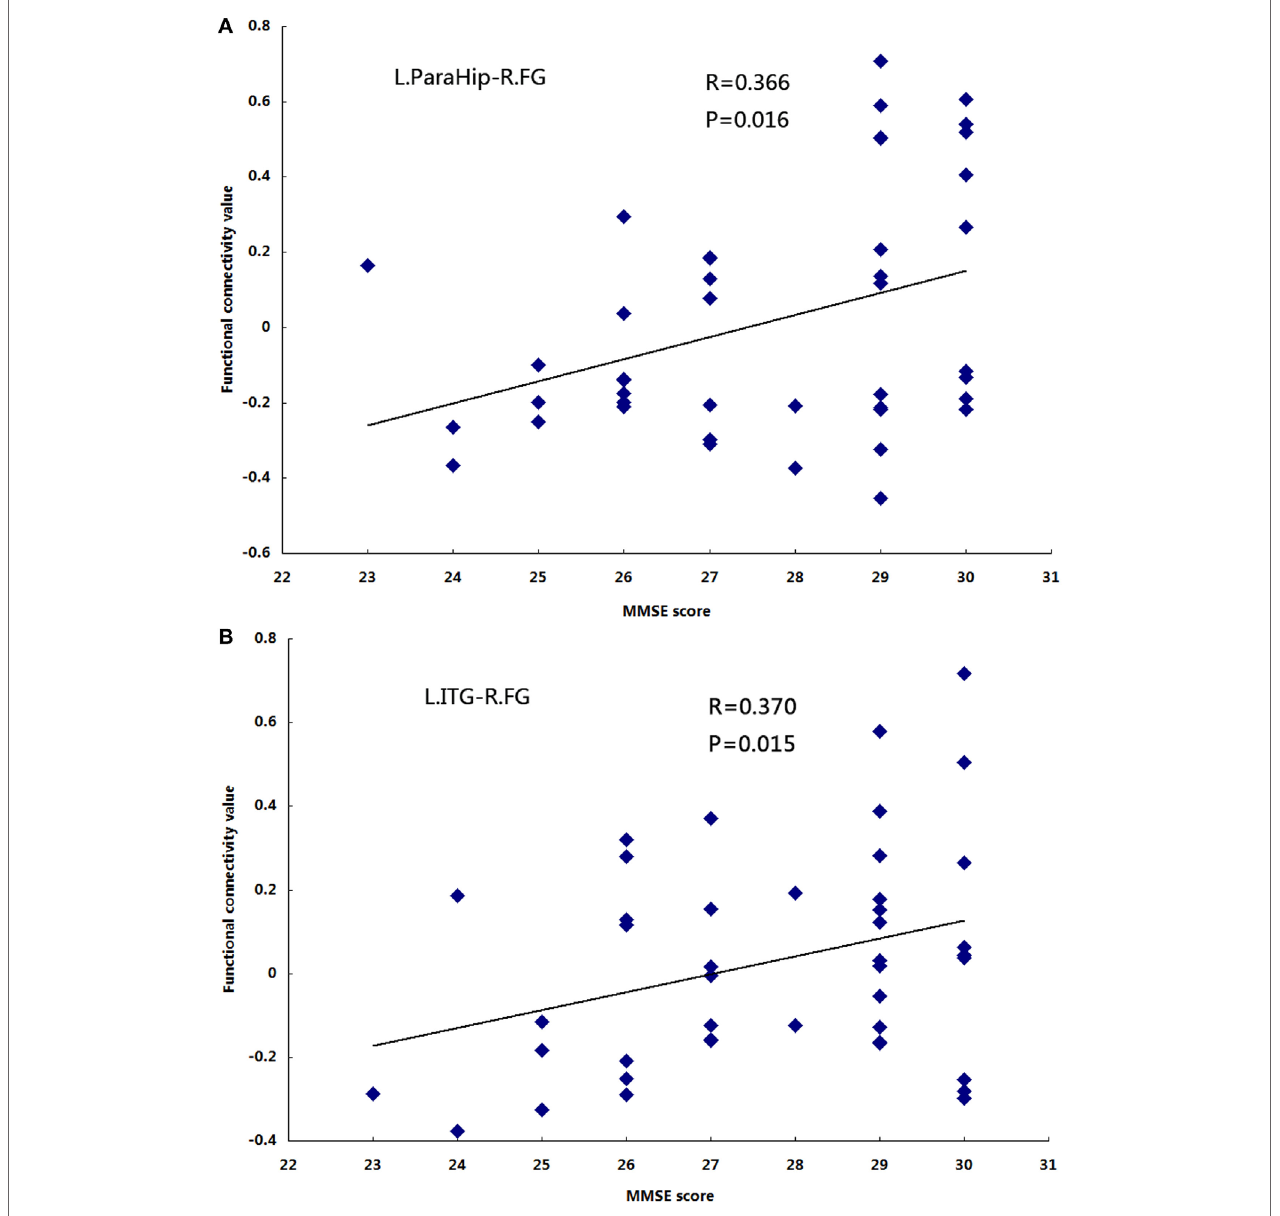
left ParaHip and right FG; (B) L.ITG-R.FG: the strength of functional connectivity between the left ITG and right FG. For details, please